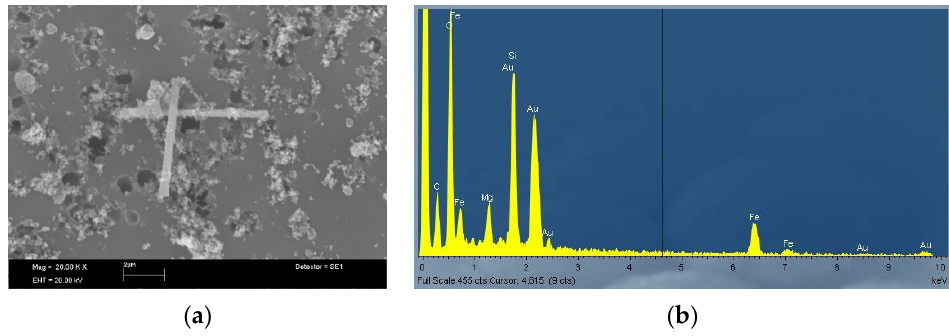
Figure 4. SEM image of airborne amosite fibers collected in building A on polycarbonate filter ( a ) and related EDS spectrum ( b ). ( a ) and related EDS spectrum ( b ).